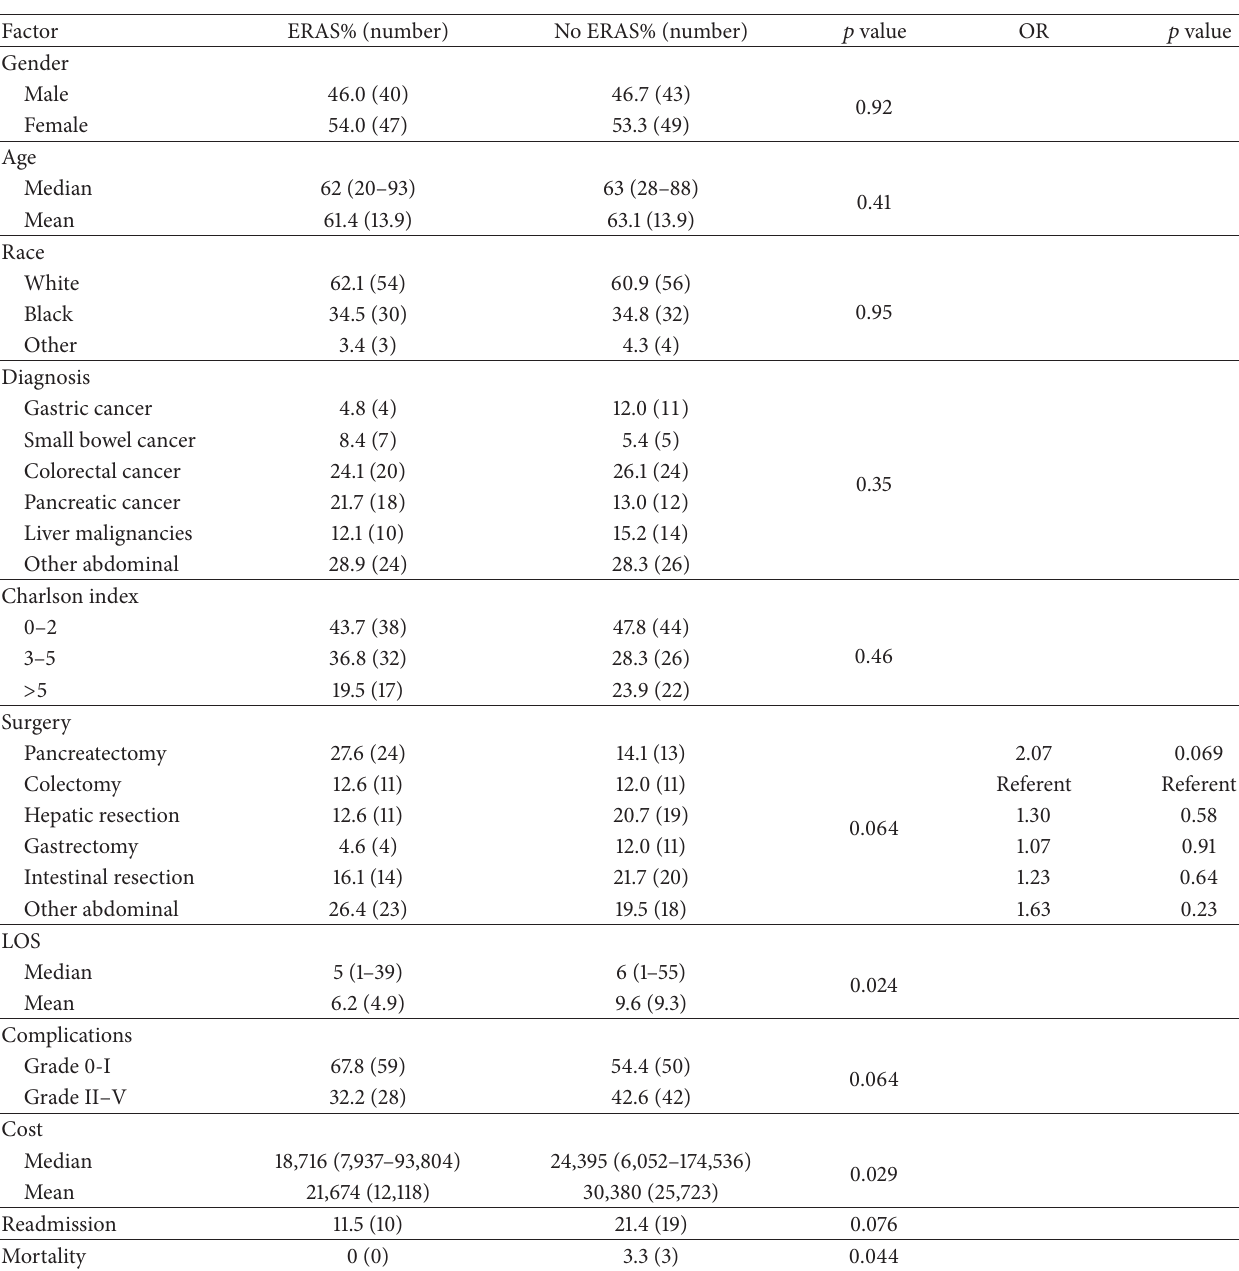
Table 4: ERAS versus non-ERAS (control) for test surgeon,